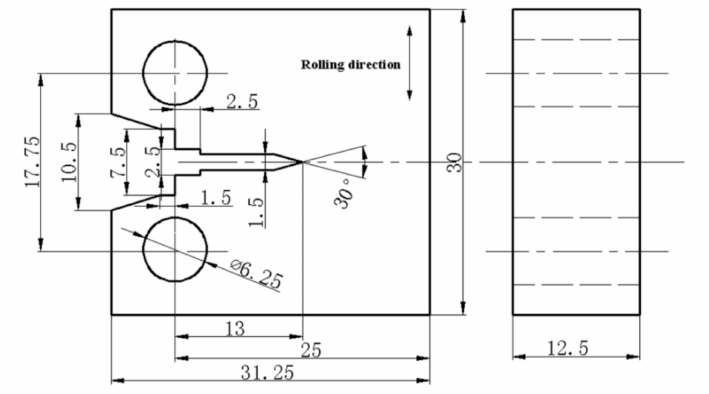
Figure 8. Size of the CT